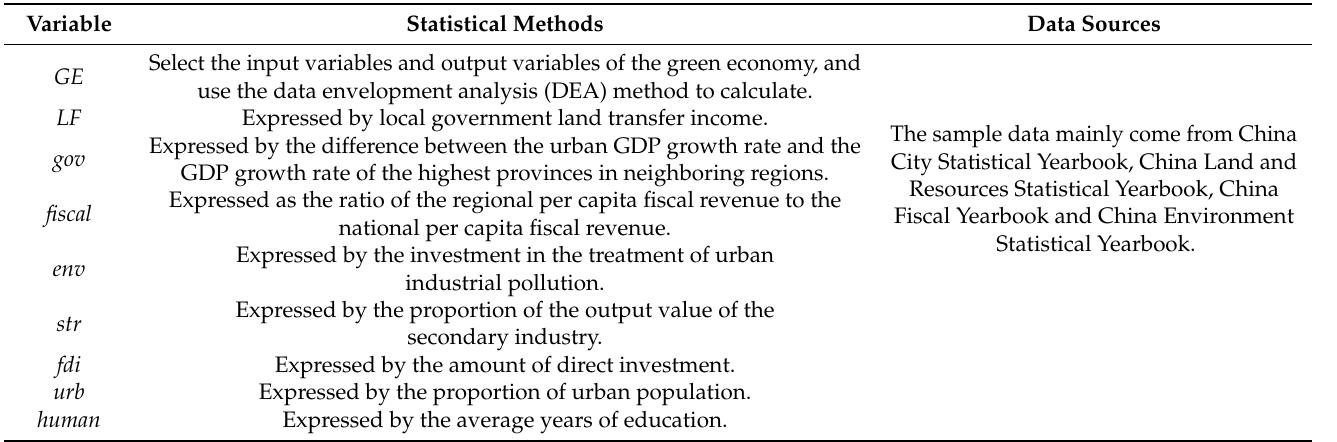
Table 1. The calculation methods and data sources of variables.